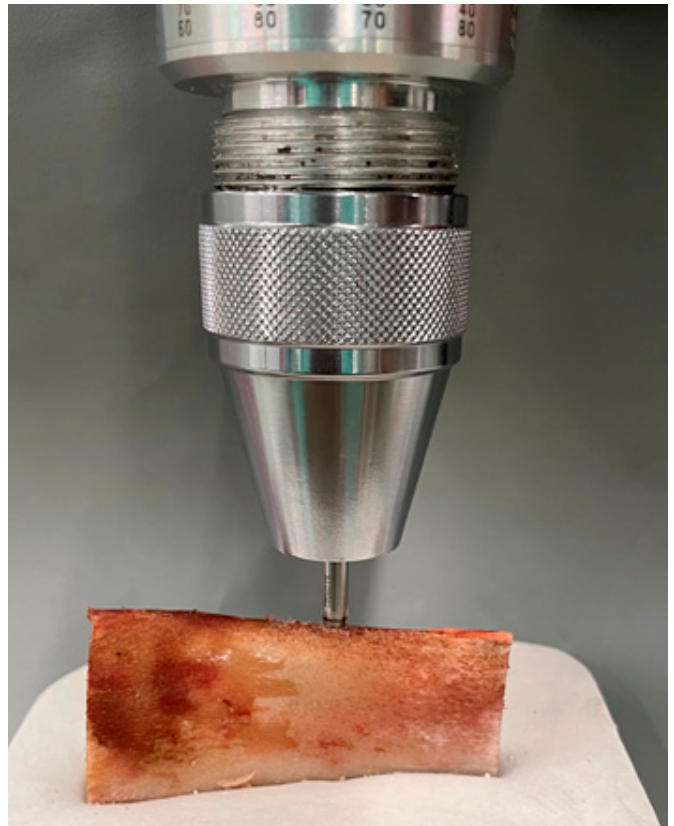
Figure 2. Placement of the implant, in the surgically shaped bone bed, using a calibrated torque meter, to record the insertion torque in Ncm.